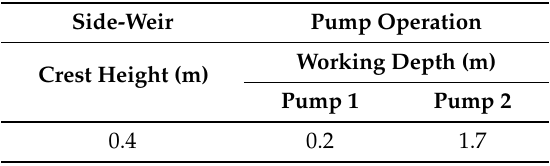
Table 2. Optimal decision variables of the detention